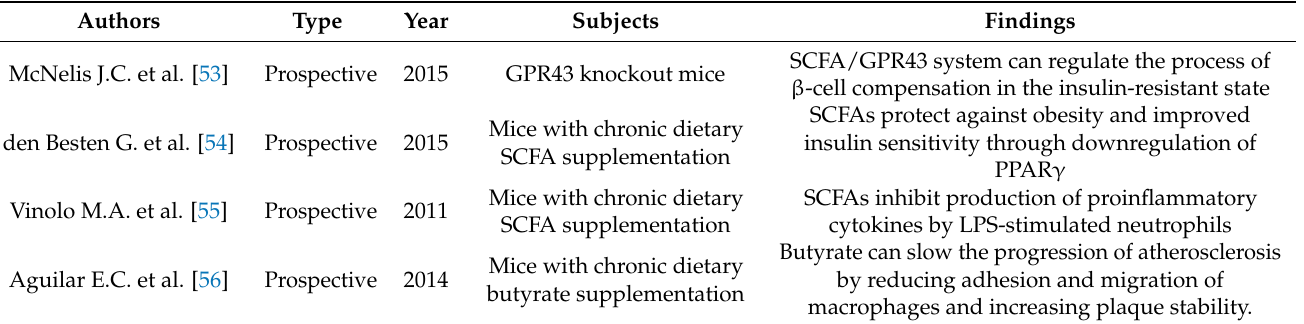
Table 3. Studies on the association between SCFAs and cardiovascular disease.